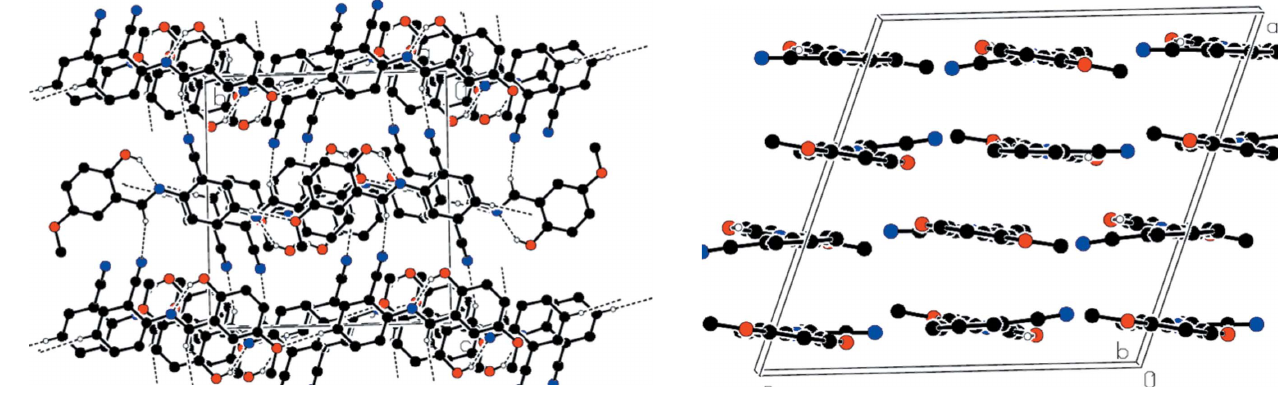
Figure 2 Part of the crystal structure with weak C—H (cid:3)(cid:3)(cid:3) O and C—H (cid:3)(cid:3)(cid:3) N hydrogen bonds shown as dashed lines.